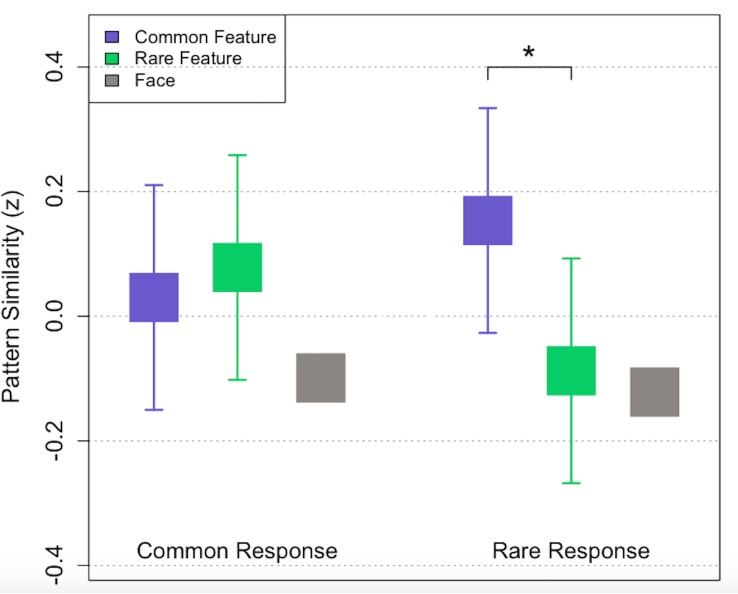
Multivoxel pattern similarity to common and rare stimulus features for ambiguous trials in which participants made common (left) and rare (right) responses (mean ± SEM).Purple squares correspond to the objects/scenes associated with the common category, while green squares correspond to the objects/scenes associated with the rare category in a given trial. Gray squares depict mean pattern similarity to the non-present face dimension for both response types. *p < 0.05. No error bars are included for the gray bars because face dimensions were not included in the overall mixed effects model.